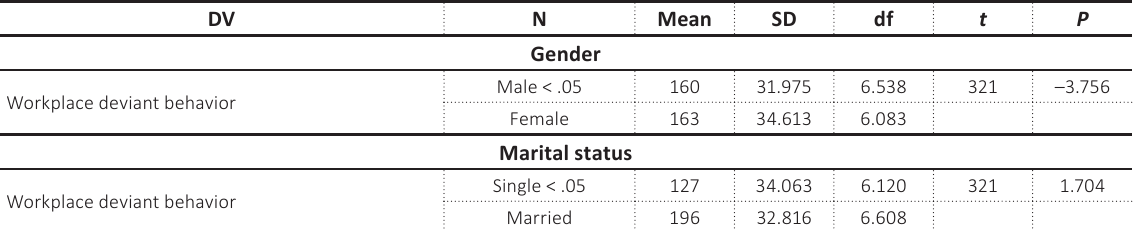
Table 4. T-test summary showing the effect of gender and marital status on workplace deviant behavior